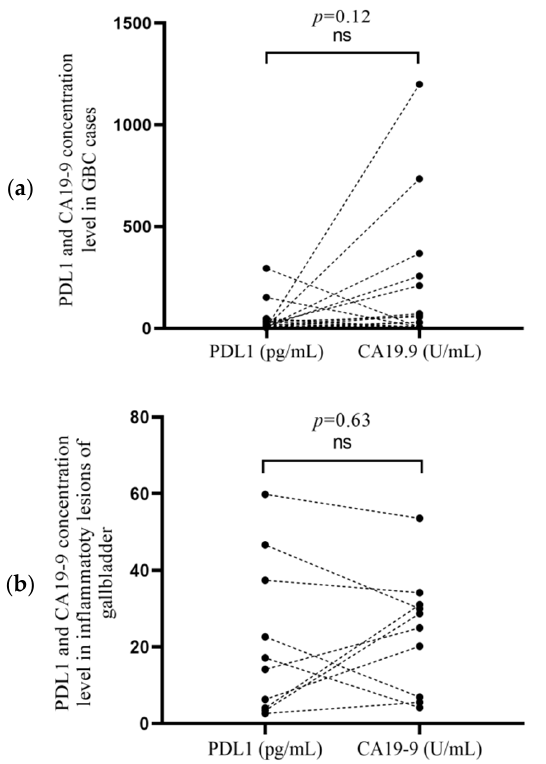
Figure 2. ( a ) PDL1 and CA19-9 concentration level in GBC cases ( n = 19), ( p = 0.12); ( b ) PDL1 and CA19-9 concentration level in inflammatory lesions of gallbladder ( n = 10), ( p = 0.63).